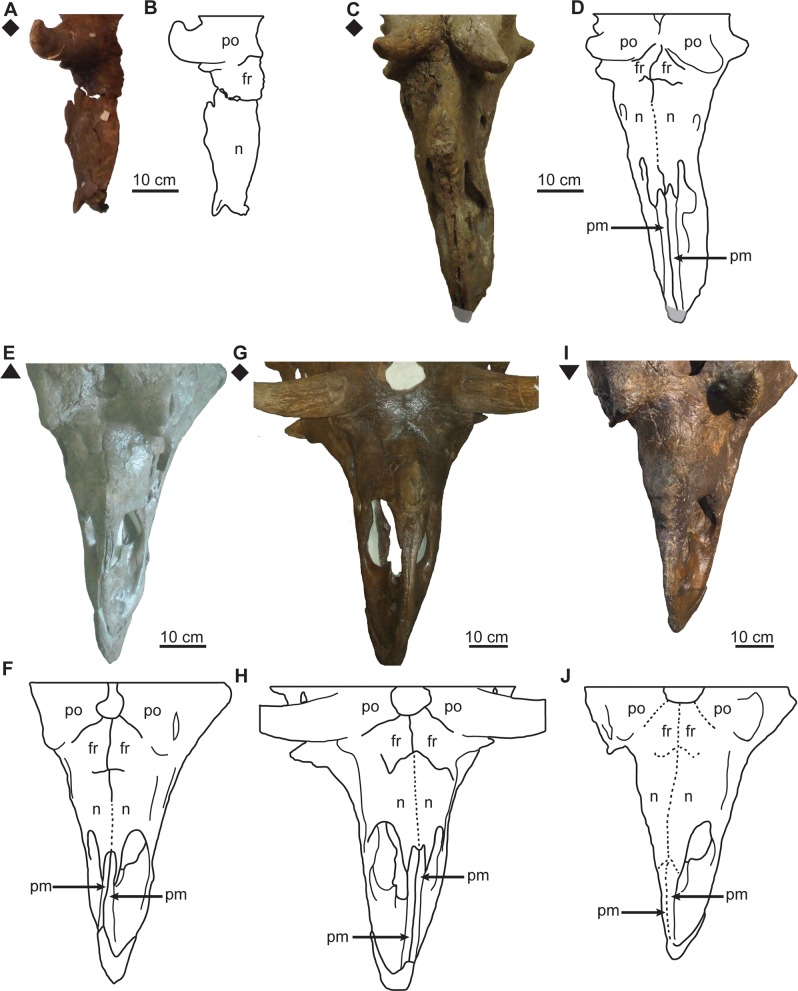
Ontogenetic changes in skull roof of Chasmosaurus.Articulation between: premaxillae (character 5), premaxilla-nasal (character 6), nasals (character 7), nasal-frontal (character 8), frontals (character 9), and frontal-postorbital (character 10): (A–B) CMN 1254, (C–D) UALVP 40, (E–F) AMNH 5402, (G–H) AMNH 5401 (courtesy of J. Mallon), and (I–J) CMN 2280. Solid lines = open sutures; dotted lines = closed sutures; plaster reconstruction = grey. Chasmosaurus belli (triangle), Chasmosaurus russelli (inverted triangle), and Chasmosaurus sp. specimens (diamonds). [planned for page width].